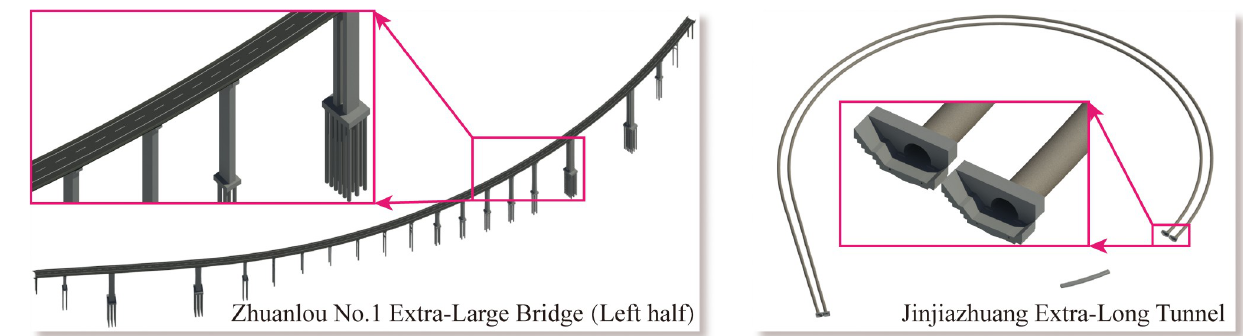
Fig 5. The main bridges and tunnels BIM models.